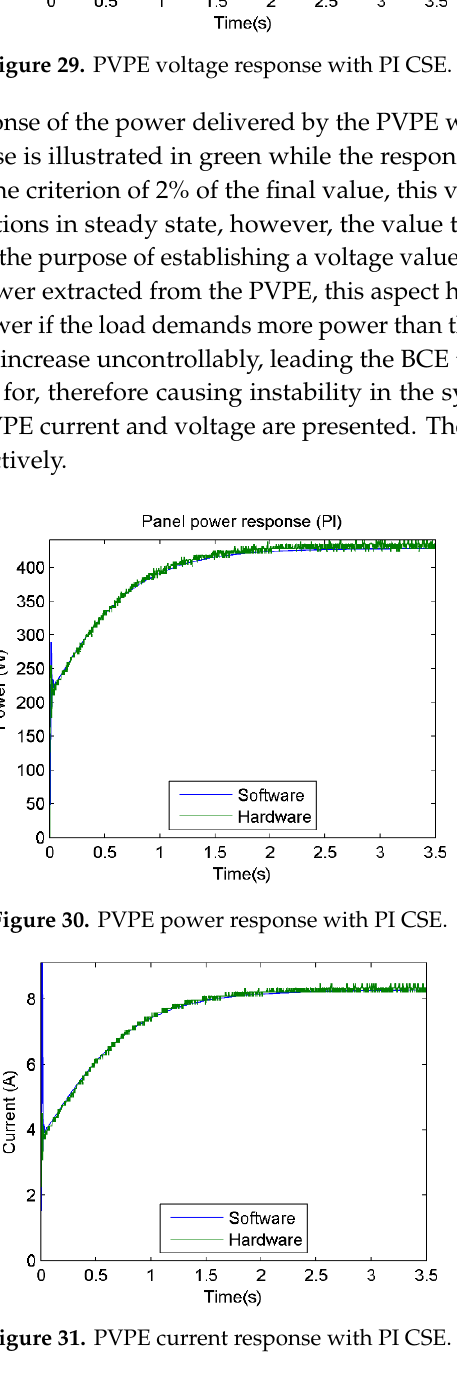
Figure 32. PVPE voltage response with the PI CSE. 5. Discussion and Conclusions The HIL system developed in this study simulates the PVS with integration times of 10 µs, this timing, although turning out to be longer compared to the studies developed in commercial platforms, is similar to the results obtained in research reported in the literature; [32] obtains simulation periods between 1.1 and 19.9 ms, [43] reports periods of 20 µs, the platform developed by [46] presents periods of 5 µs, in the study by [44] results for this 10 µs variable are reported, [47] reports periods between 200 ns and 2 µs, in [42] a period of 1 ms is used and finally [40,41] report periods of 50 µs. On the other hand, if the response of the PVSE presented in Figure 22 is analyzed as a first order system, it would have a time constant of approximately 990 microseconds, which means that with the integration time of the PVS around 99 values are calculated for the output for each time constant, allowing to emulate a continuous signal. The proposed investigation was developed using generic software, obtaining integration times similar to dedicated platforms, but at a lower cost. The HIL platform of the PVPE allows the generation of different I-V curves for PVPs by manipulating the values of the desired power in real time, giving the user the option to check the behavior of the controllers reproducing diverse climatic changes, offering advantages in the experimental stage compared to real systems, in which the climatic conditions cannot be manipulated, or in proposals where the I-V curve emulated by the platform is unique [45]. The proposed HIL platform is programmed in an environment with high-level graphic language that allows researchers and educators to reproduce and reconfigure the proposed emulator in a faster and easier way compared to methodologies that propose the use of multiple software, for example [42] that proposes the use of VHDL as a programming language. Concerning the accuracy of the system, when comparing the results obtained with the software simulation, the emulator presented a mean absolute error of 1.0930 V and a mean percent error of −2.0478%. These values tend to be large in the samples taken at the start of the converter output voltage response. The period in which the error obtained is greater corresponds to the time in which the output takes small values, close to zero at the beginning of this period, so that, although the error